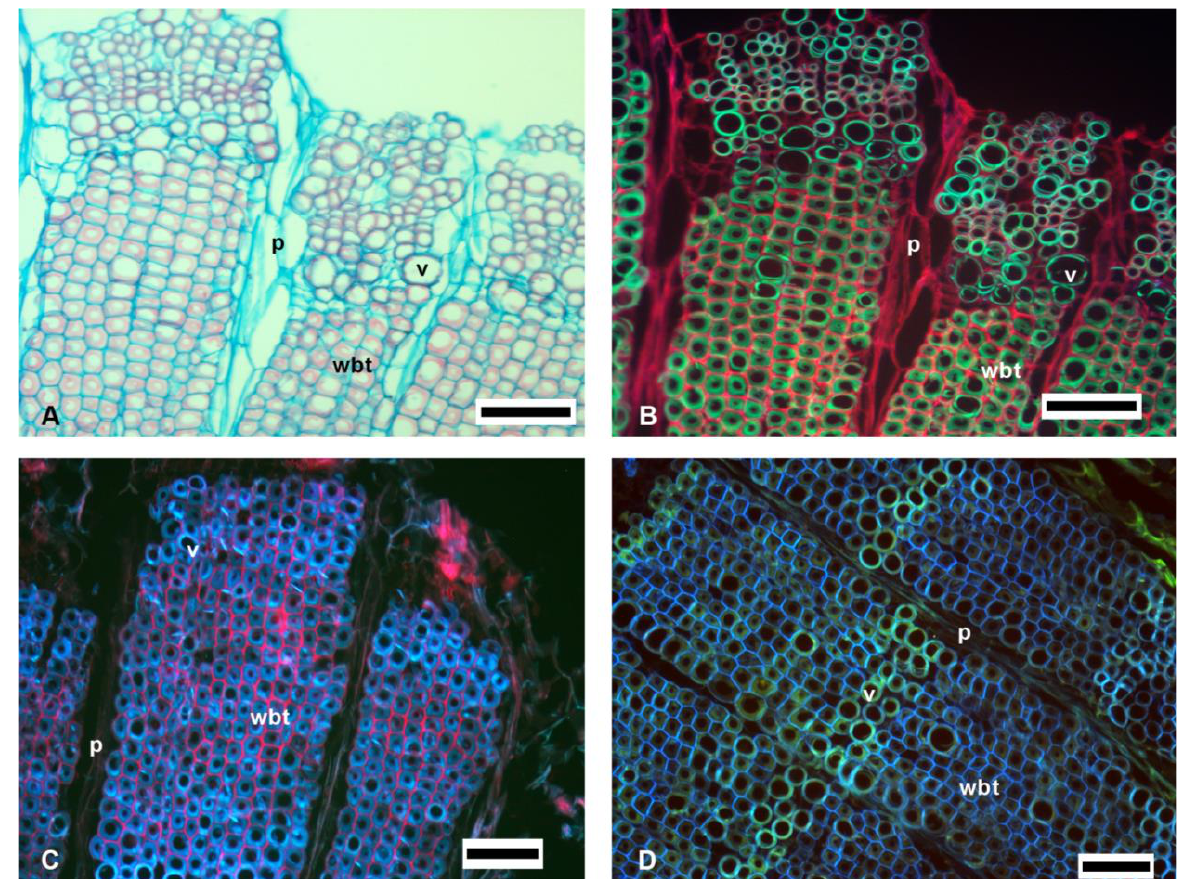
Figure 2. Images of the vascular tissue of F. latispinus . ( A ) Bright-field image of SF. ( B ) Fluorescence image of SF. ( C ) Fluorescence image of AO. ( D ) Fluorescence image of CA. p = parenchyma, v = vessel, wbt =wide-band tracheids. Scale: 100 µm.